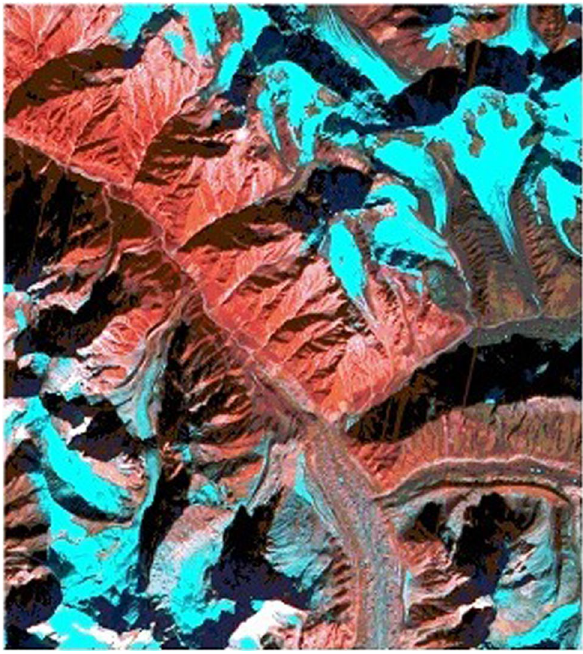
Fig. 2 LISS-III satellite data of the Gangotri glacier, Garhwal Hima-